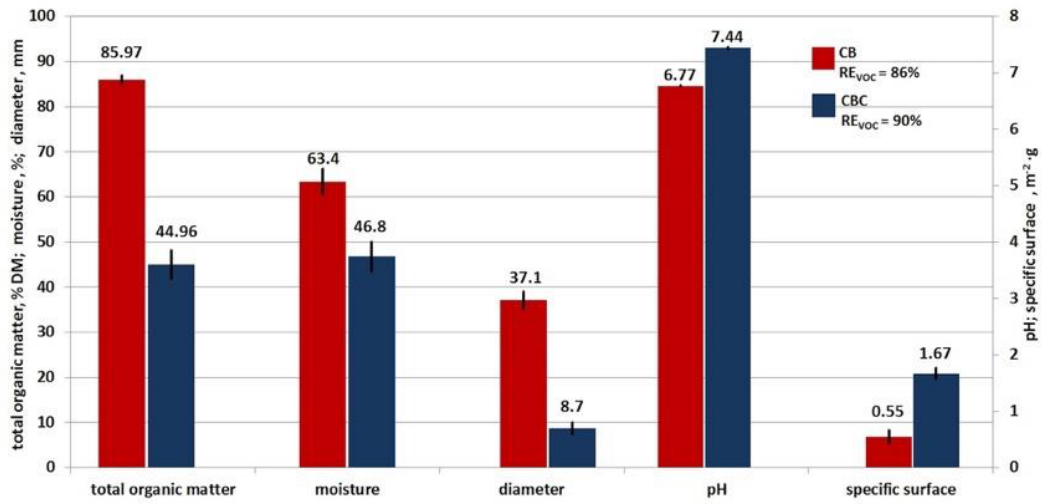
Figure 6. Technical parameters of the used fillings collated with the VOC removal e ff ectiveness–mean values. Table 5. Technical parameters of the biofilter filling materials–values for each measurement series and mean values.